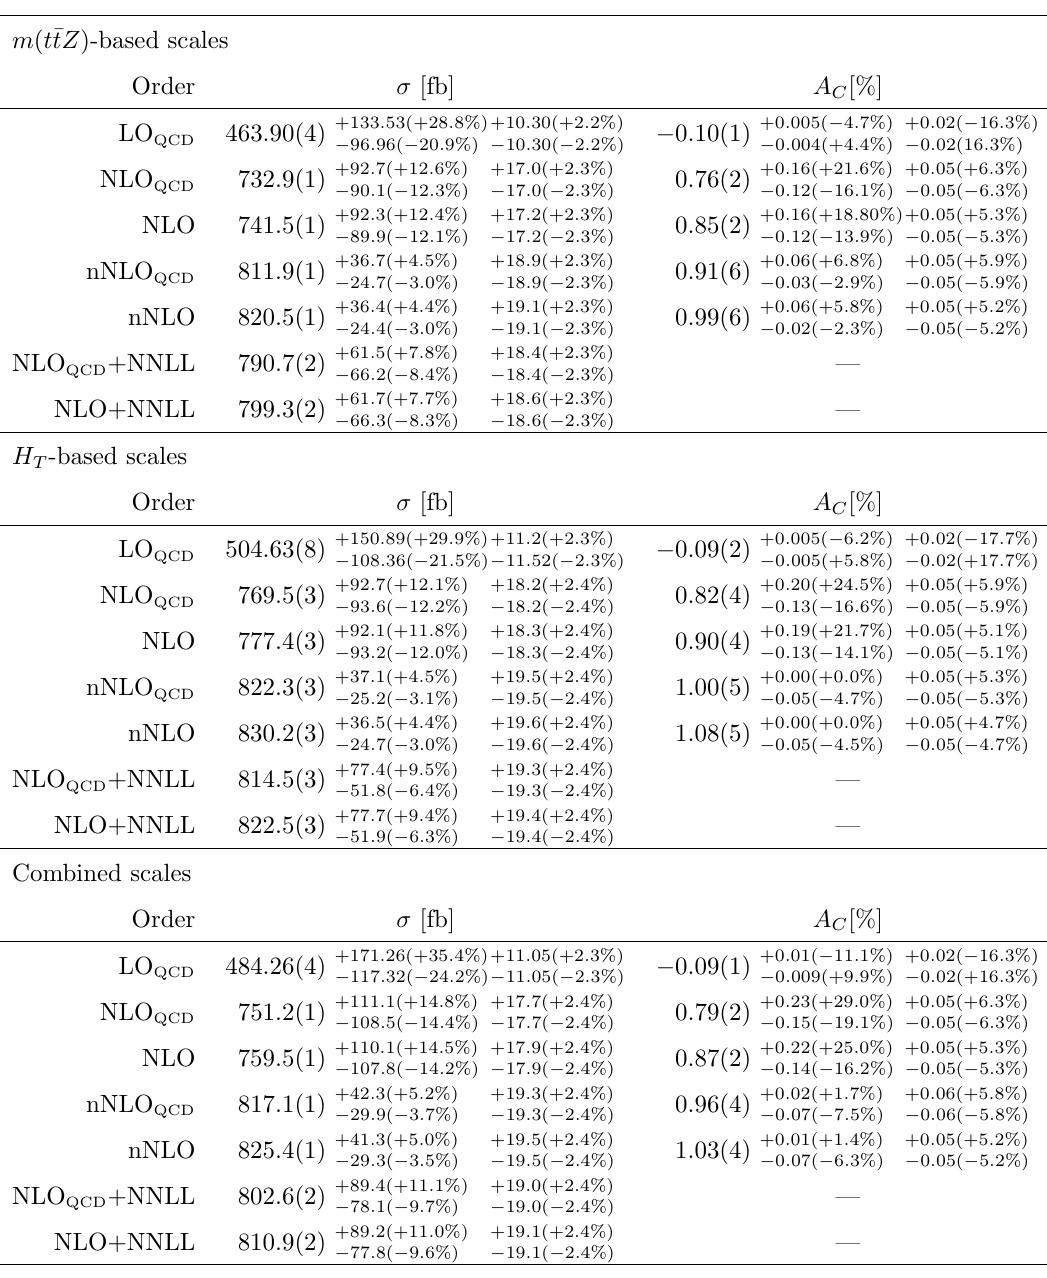
Table 4 . Total cross section and charge symmetry for t (cid:22) tZ production. Same structure as in table